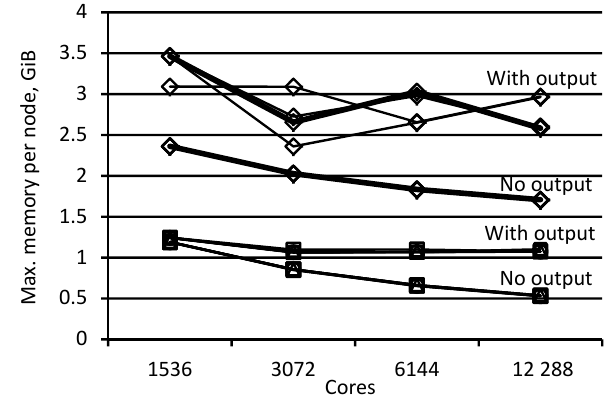
Figure 9. Speed-up calculated to the baseline of 64 nodes (1536 cores) for each test case. Symbols match those in Figs. 4–7. Labels mark simulations with and without output. For “MESSy + GRAGG”, the lower four series are speed-ups for simu- lations with GRAGG operating on the full temporal resolution. The dashed grey line represents optimal speed-up.